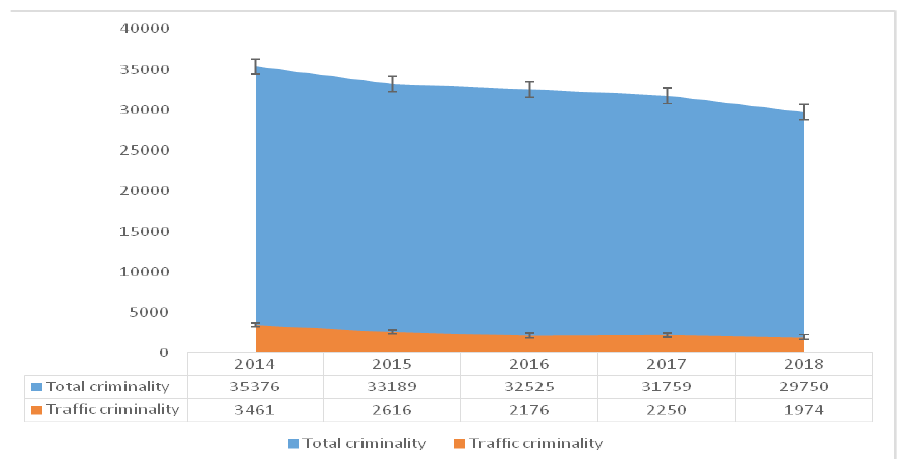
Chart 2: Share of traffic criminality within the total criminality in the Republic of Serbia in period